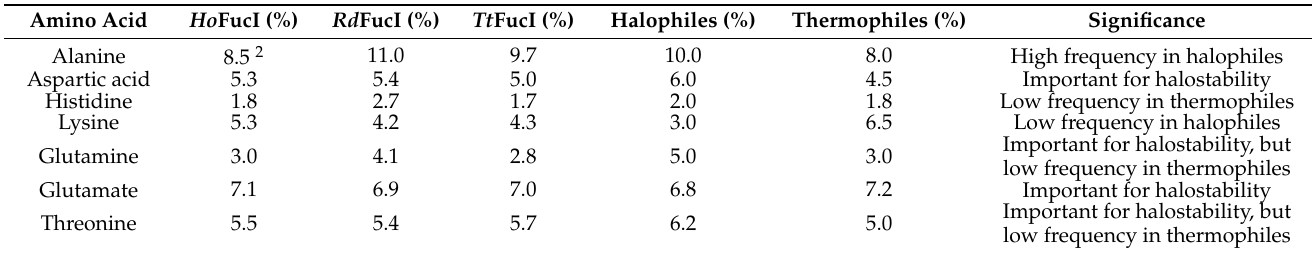
Table 2. The content of several amino acid residues related to halophilic properties in Ho FucI, L -FucI from Raoultella sp. ( Rd FucI), L -FucI from Thermanaeromonas toyohensis ( Tt FucI), and proteomes from general salt-in halophiles and thermophiles 1